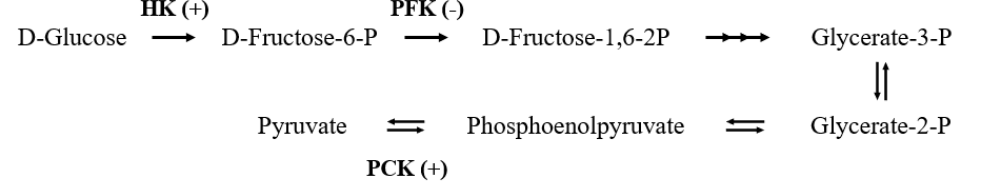
Figure 4. Glycolysis and gluconeogenesis processes and related DEPs. Compared with CON groups, ( + ) upregulated, (-) downregulated.